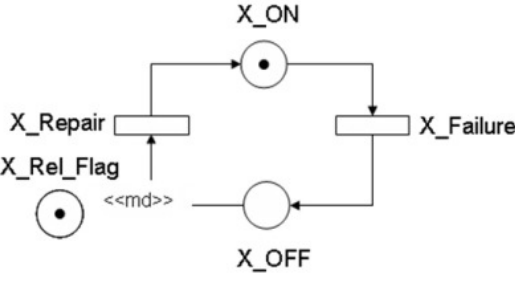
Figure 7. Simple component model.